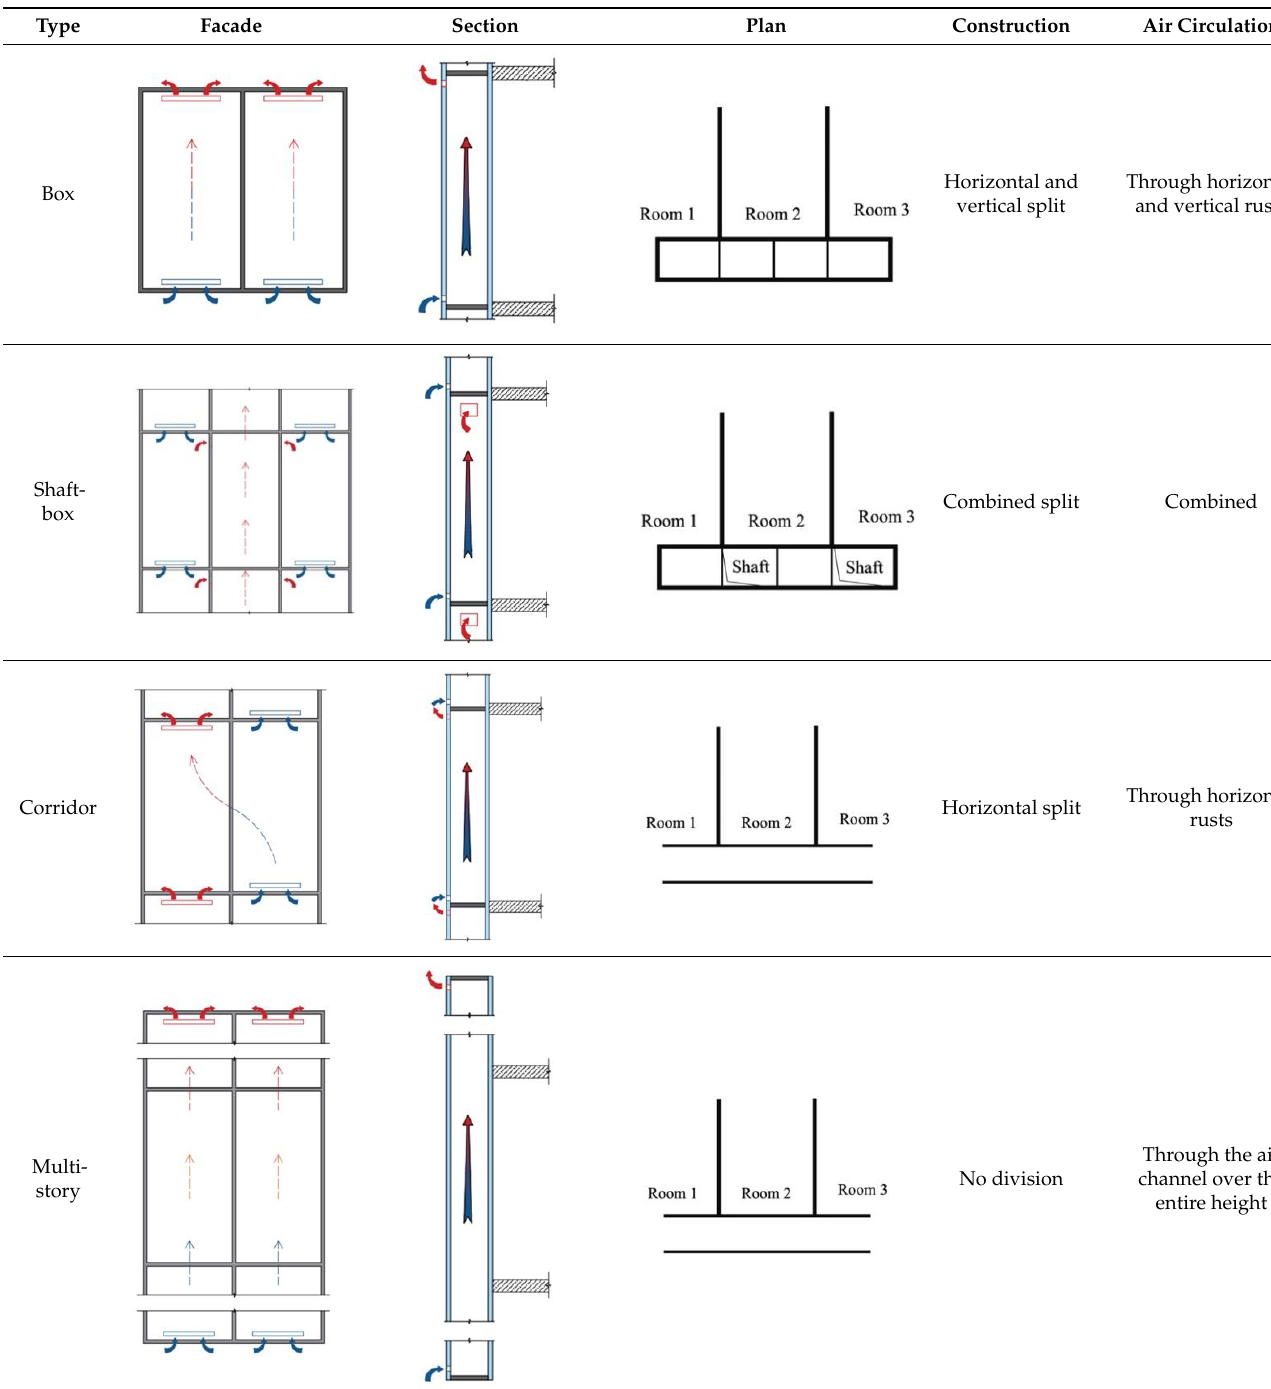
Table 1. Connection types for ventilated facades.